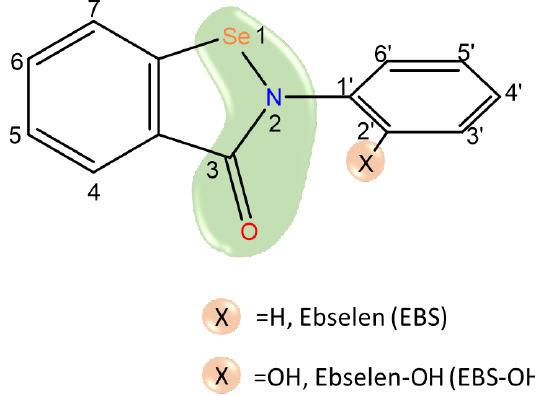
Scheme 1. Sketch of ebselen, X group in position ortho of the phenyl ring can be H (EBS) or OH (EBS-OH). Ebselen warhead is evidenced in green.